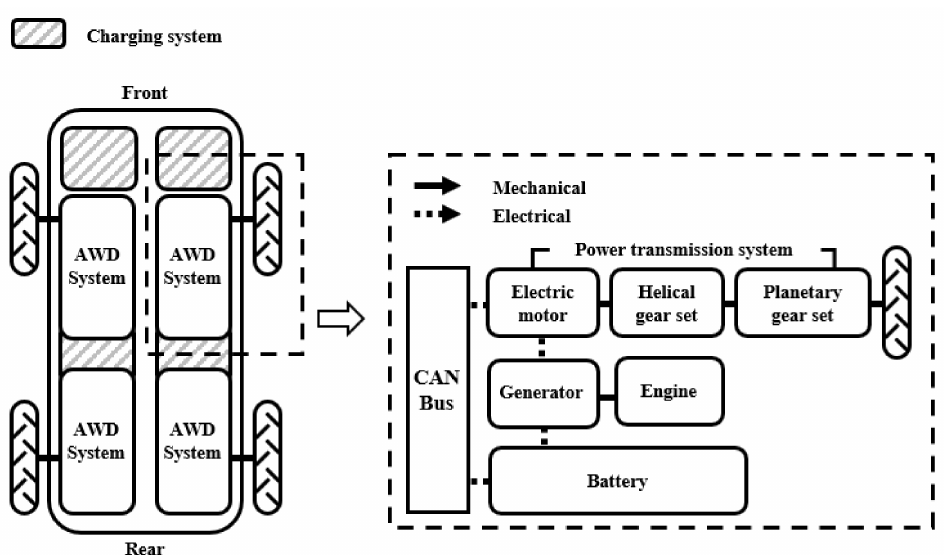
Figure 1. Schematic of the power transmission system of the electric AWD